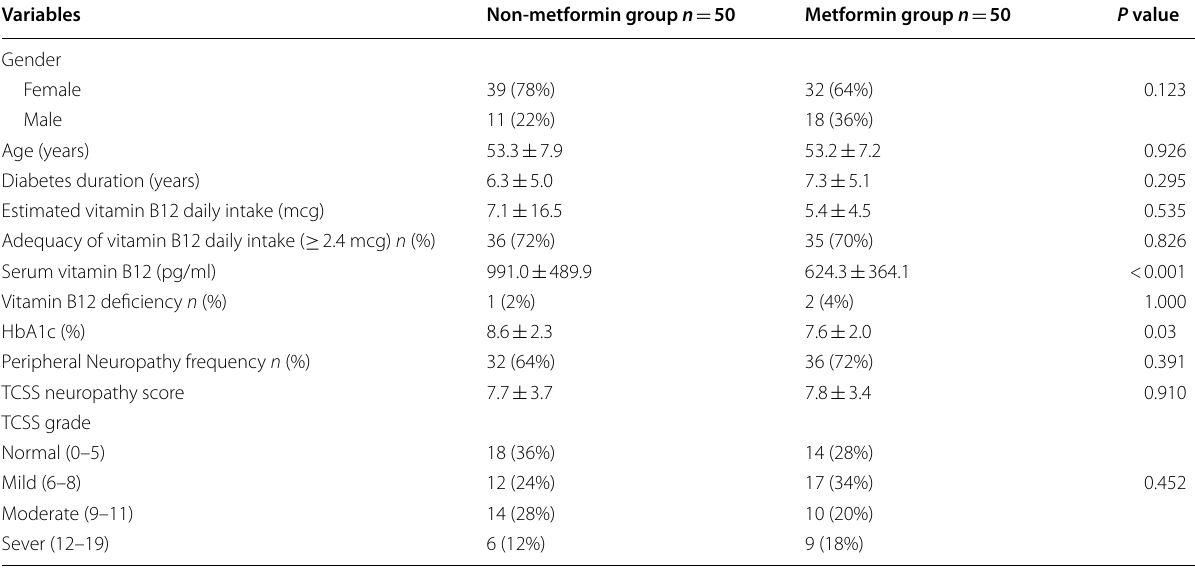
P value < 0.05 significant; P value < 0.01 highly